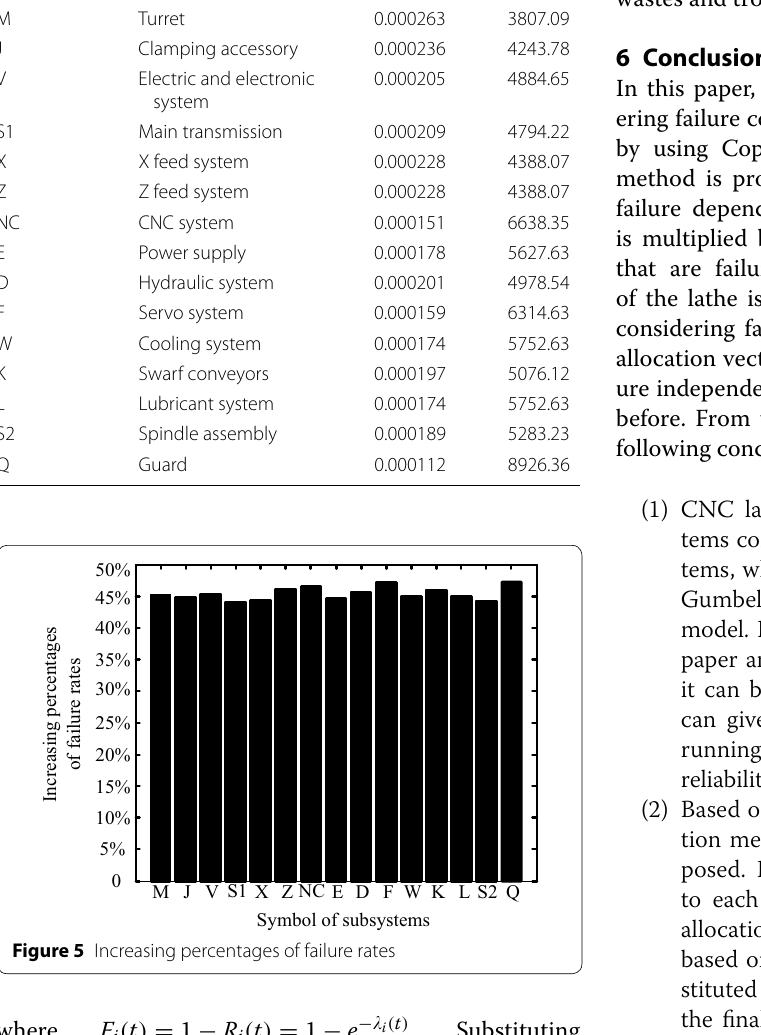
Table 3 Allocation results considering failure correlation Symbol Subsystems of subsystems